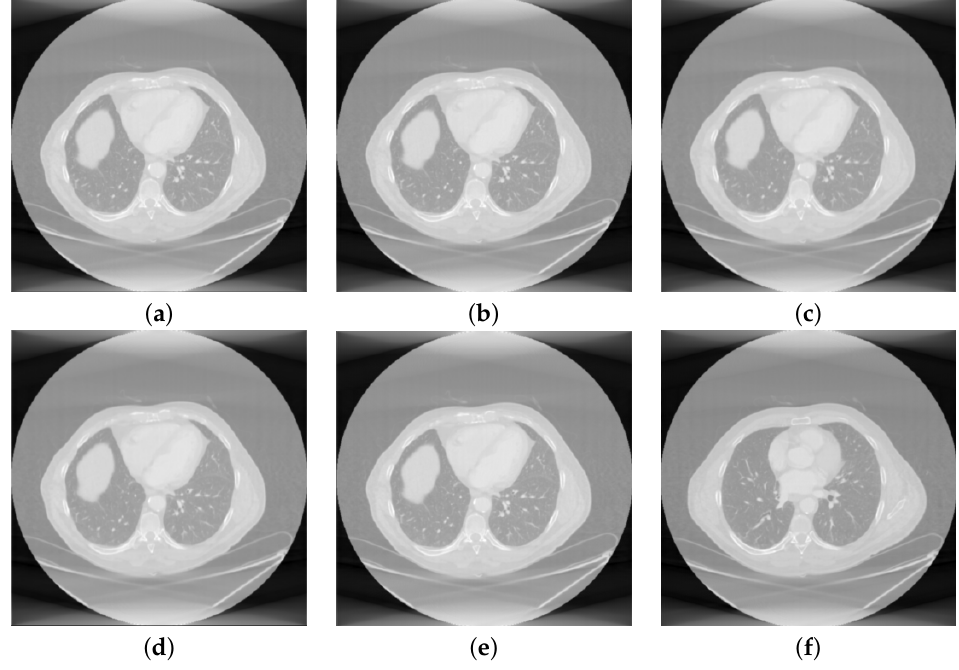
Figure 5. Slices of the reconstructed model at Td y = − 29.02 mm based on the proposed method. ( a ) Case 1; ( b ) Case 2; ( c ) Case 3; ( d ) Case 4; ( e ) Case 5; ( f ) Case